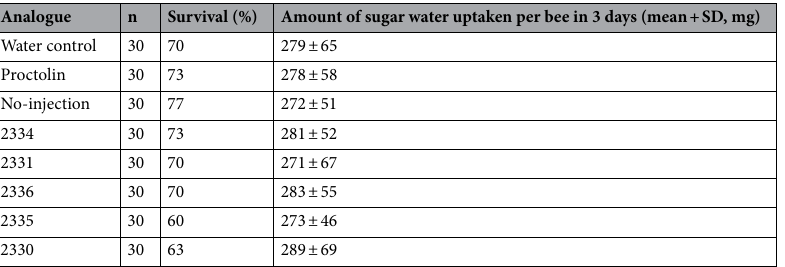
Table 2. Percent survival of honey bee ( Apis mellifera ) and amount of sugar water uptake after injections of proctolin analogs. Sugar water consumption was measured at the day 3 and the survival was counted in the seventh day after treatment. The statistics were a Chi-square test for the survivorship and Student’s t-test for the sugar water consumption. No statistical difference compared to the water control was found at the P = 0.05.